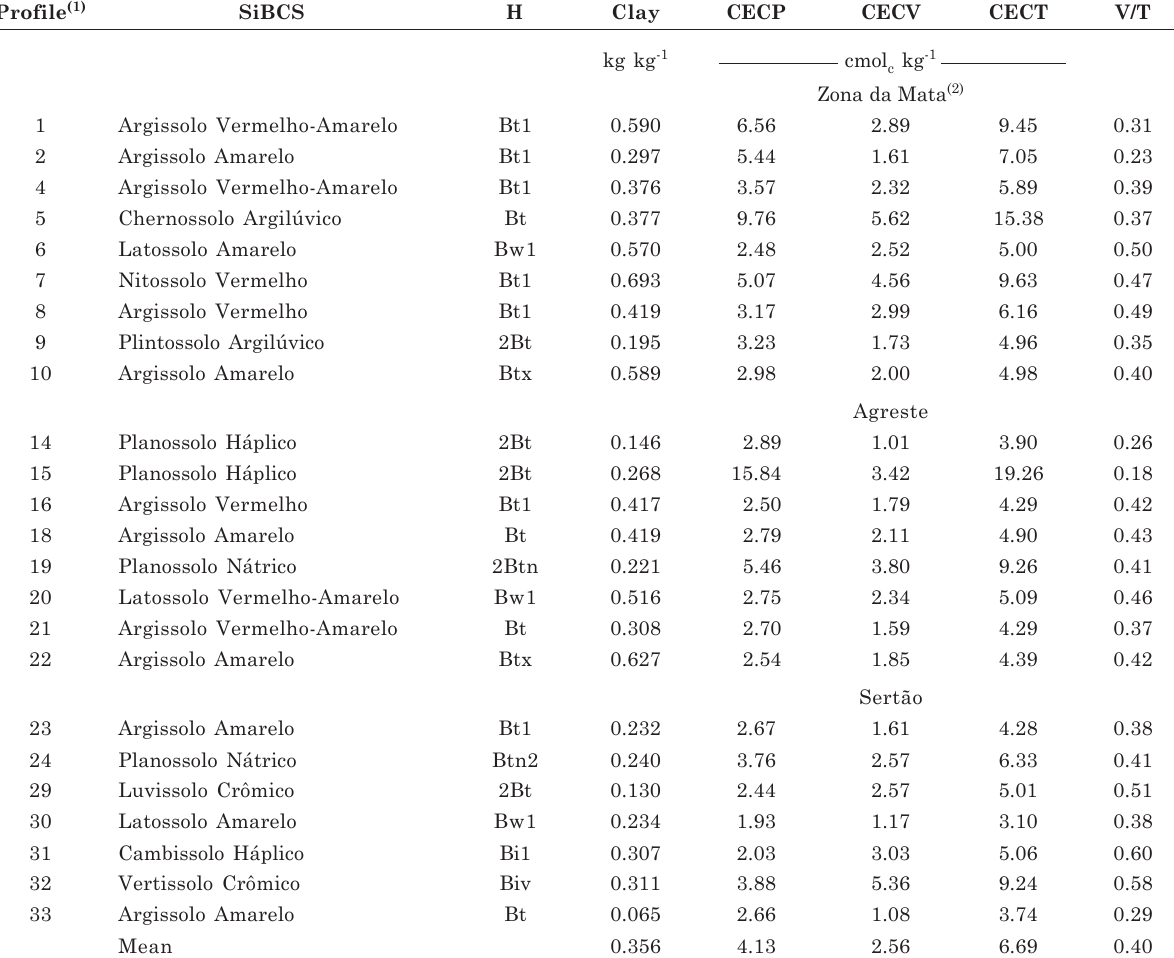
Table 3. Clay content, permanent cation exchange capacity (CECP), variable cation exchange capacity (CECV), total cation exchange capacity (CECT = CECP + CECV) and relation CECV/CECT (V/T) in the sampled horizons (H) of reference soils of the State of